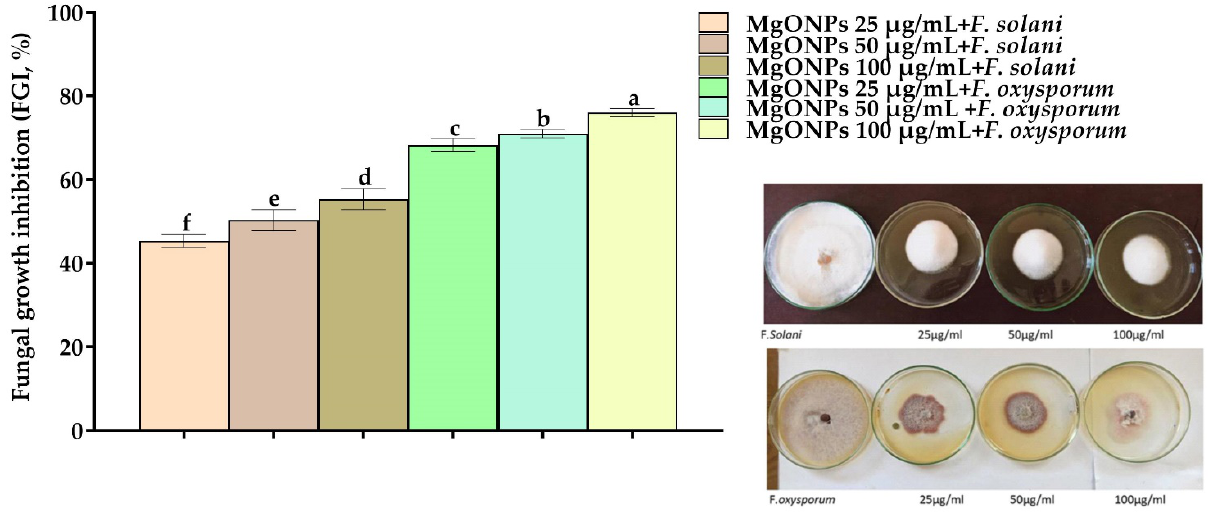
Figure 1. The fungal growth inhibition (FGI%) of MgONPs at different concentrations (25, 50, and 100 µg/mL) on F. solani and F. oxysporum on NA media. a–f Columns with different superscripts are significantly different at p <